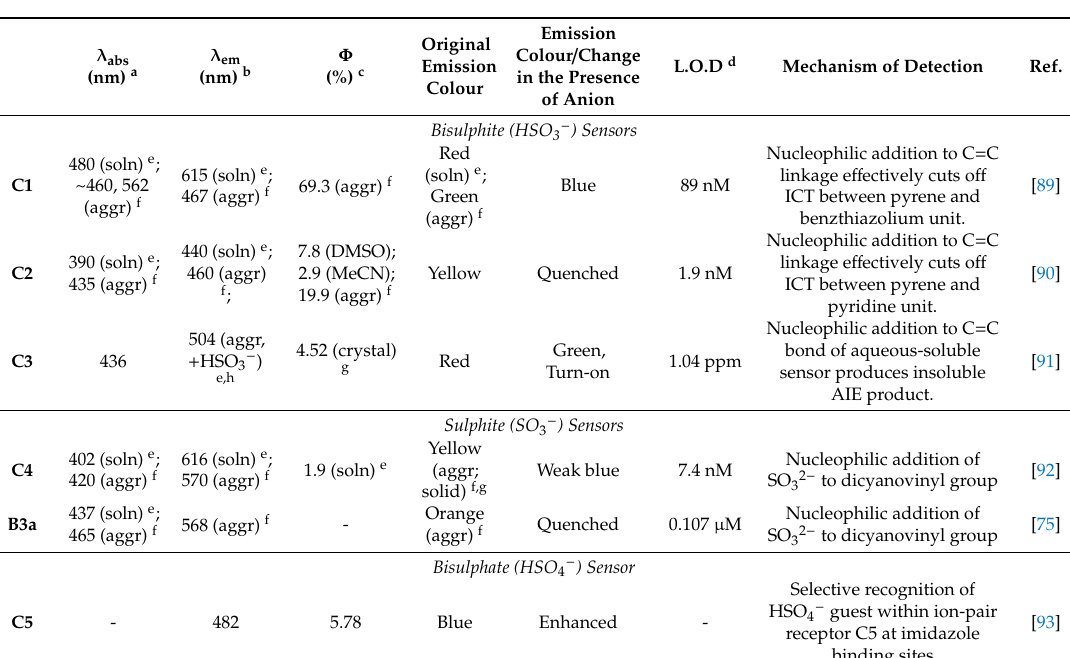
Scheme 7. Chemical structures of AIE-based bisulphite, sulphite and bisulphate chemosensors C1 – C5 , and their general sensing mechanisms. Table 6. Summary of optical properties and sensing performance of AIE-based bisulphite, sulphite and bisulphate chemosensors C1 – C5 .